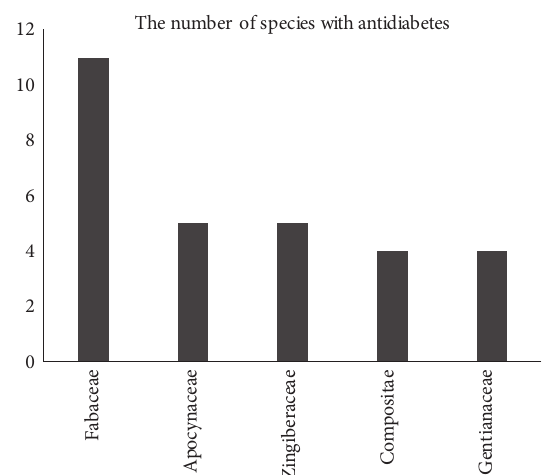
Figure 3: Top five plant families reported for antidiabetic prop- erties by